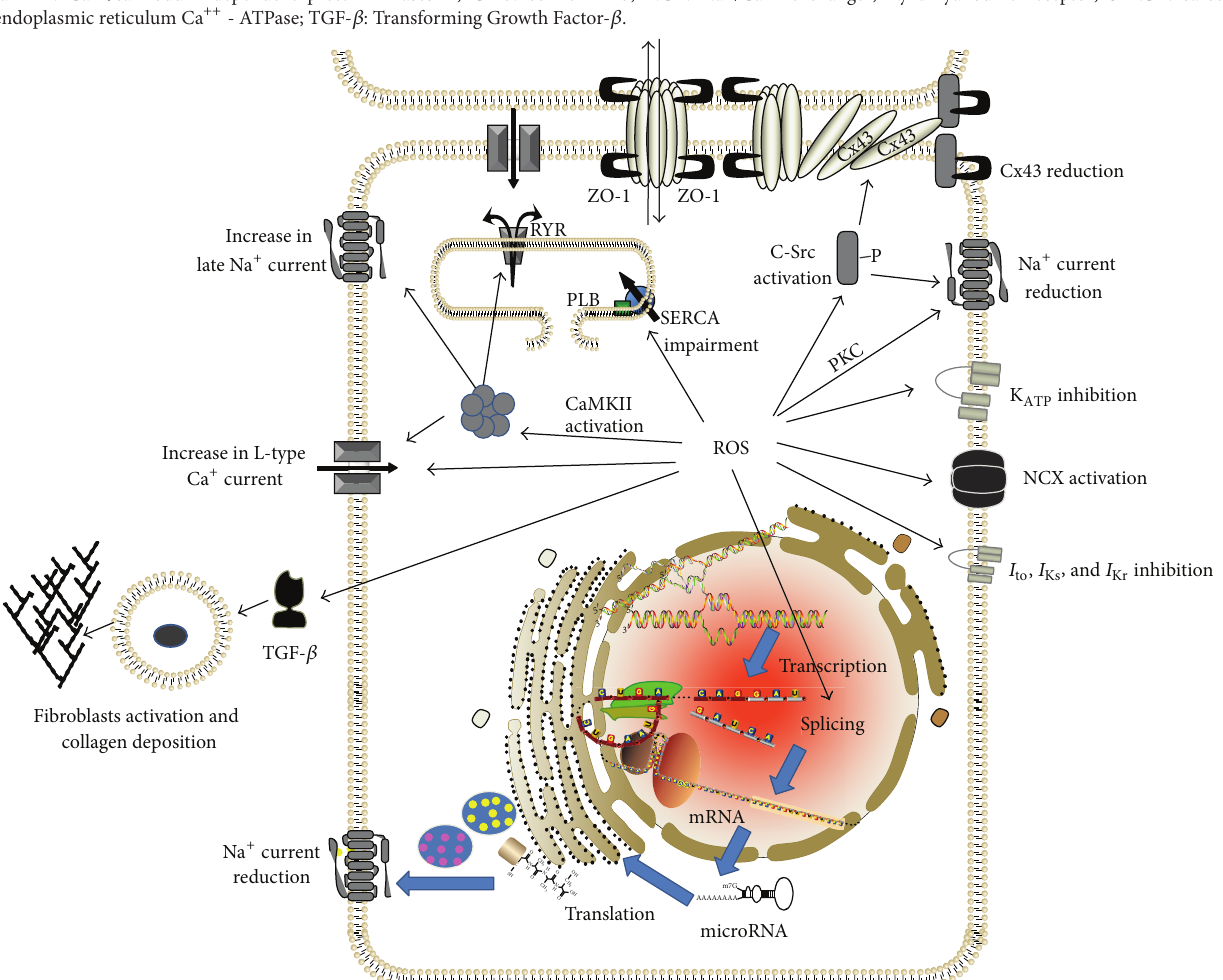
Table 1: A summary of mechanisms of oxidative stress induced arrhythmia and potential therapeutic targets. Na + current reduction (via PKC and c-Src, also via abnormal splicing) ⇒ reduction in conduction velocity KATP inhibition ⇒ repolarization abnormality NCX activation ⇒ increasing inward current and facilitating afterdepolarization Affected ion channels 𝐼 𝐼 𝐼 ⇒ abnormal repolarization to , Kr , Ks inhibition Increase in inward Ca ++ current (direct or via CaMKII activation) ⇒ facilitating afterdepolarization Increase in late Na + current ⇒ facilitating afterdepolarization Impairment of SERCA ⇒ increase intracellular Ca ++ levels ⇒ facilitating afterdepolarization Effect on intracellular Ca ++ handling Affecting RyR receptor (via CaMKII activation) ⇒ leakiness of SR ⇒ increase intracellular Ca ++ levels ⇒ facilitating afterdepolarization